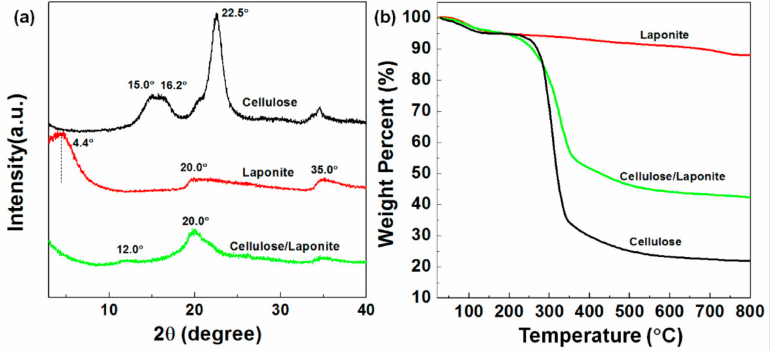
Figure 2. XRD patterns ( a ) and TGA curves ( b ) of cellulose, Laponite and cellulose/ Laponite